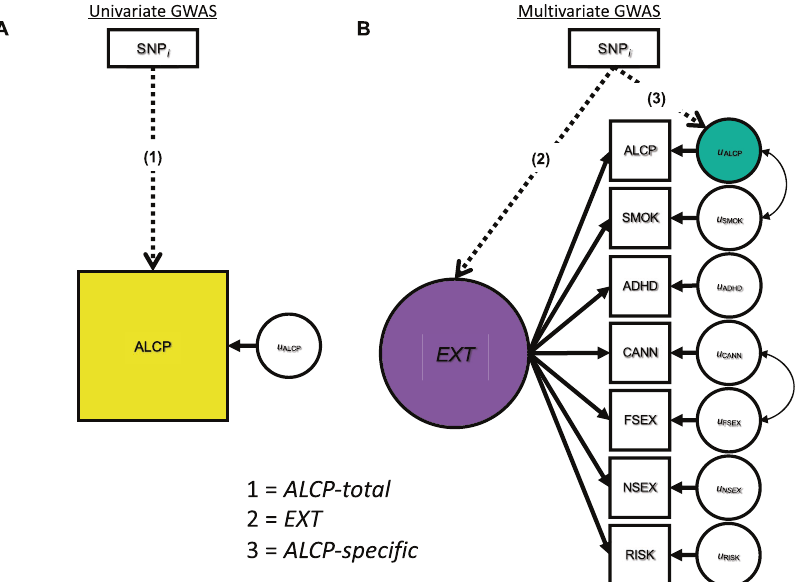
Fig. 1 GWAS Models for Problematic Alcohol Use and Externalizing. Univariate ( A ) and multivariate ( B ) GWAS models for problematic alcohol use and externalizing. The SNP associations with the yellow box labeled ALCP are referred to herein as “ ALCP-total ” (original problematic alcohol use), the SNP associations with the purple circle are referred to herein as “ EXT ” (shared risk towards externalizing), and the SNP associations with the teal circle are referred to herein as “ ALCP-speci fi c ” (problematic alcohol user-speci fi